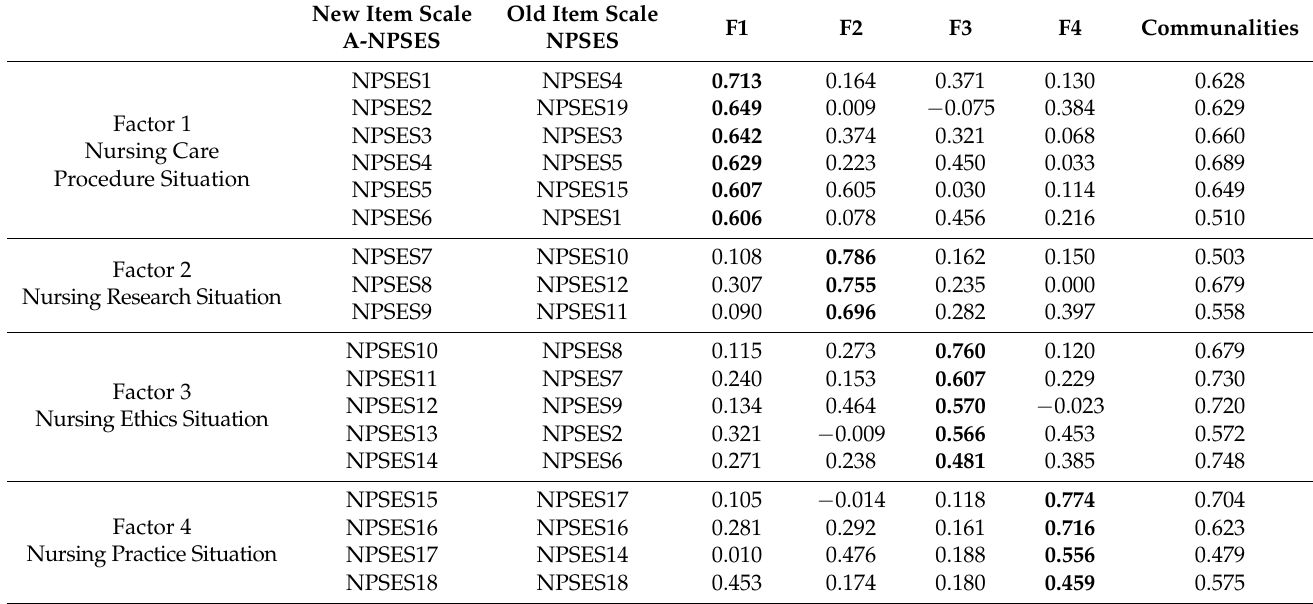
Table 3. A-NPSES exploratory factor analysis 1